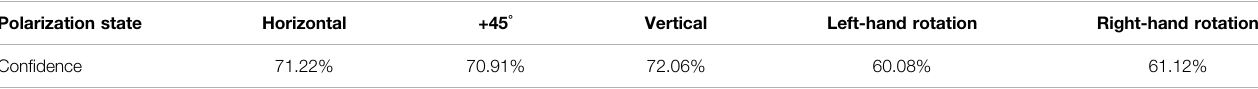
TABLE 4 | Calculation results of con fi dence of 671 nm polarized light simulation and test veri fi cation. Polarization state Horizontal +45 ° Vertical Left-hand rotation Right-hand